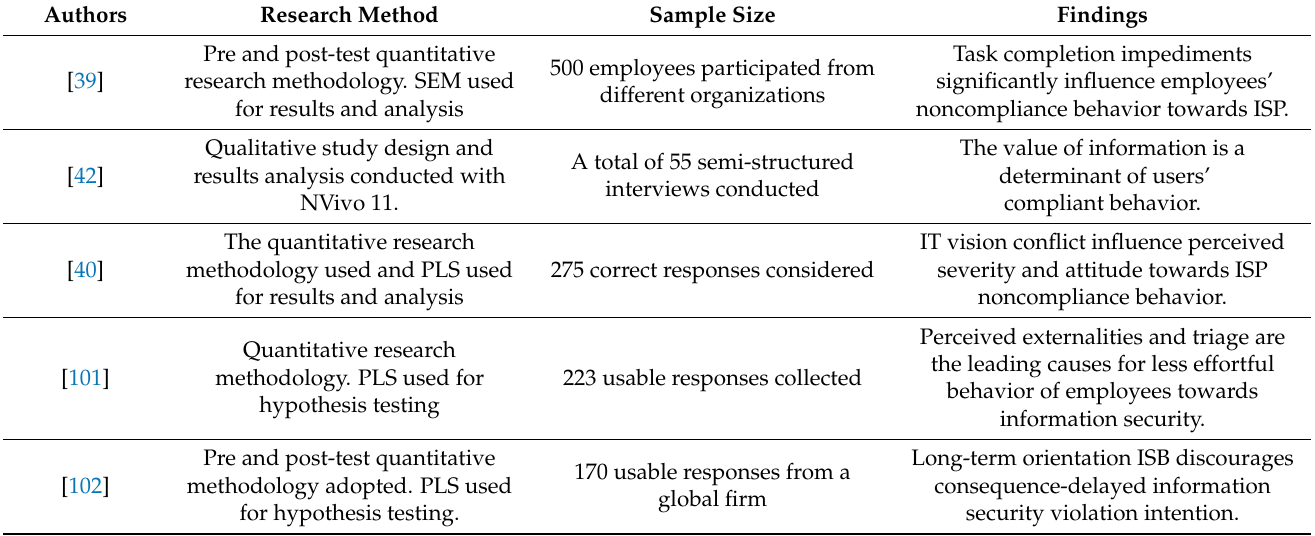
Table 12. Studies on value conflicts and